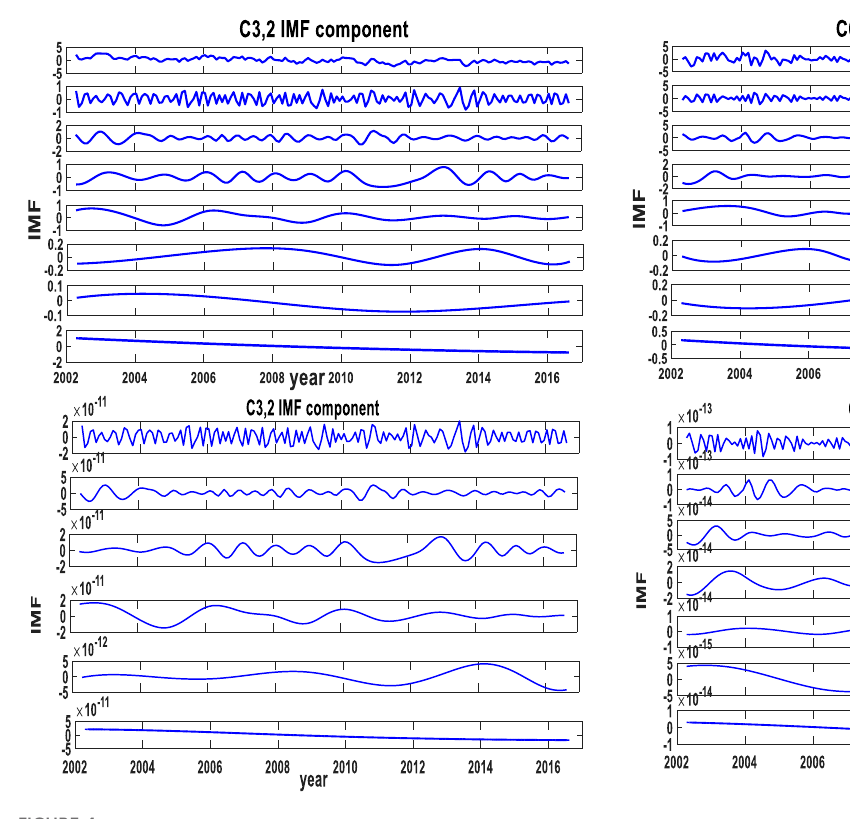
FIGURE 4 IMF components for C 3,2 and C 60,59 coef fi cients (Up: EEMD; Bottom: EMD).